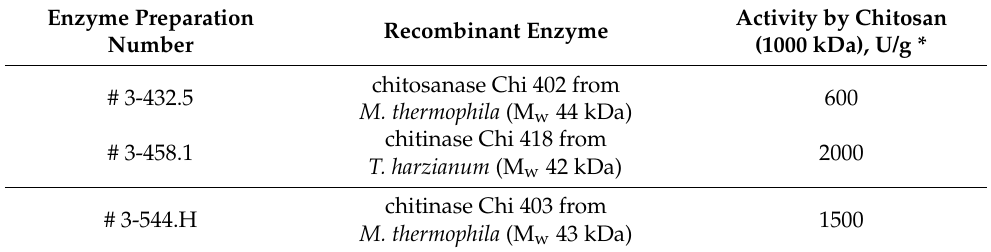
Recombinant Enzyme chitosanase Chi 402 from M. thermophila (M w 44 kDa) chitinase Chi 418 from T. harzianum (M w 42 kDa) chitinase Chi 403 from M. thermophila (M w 43 kDa)